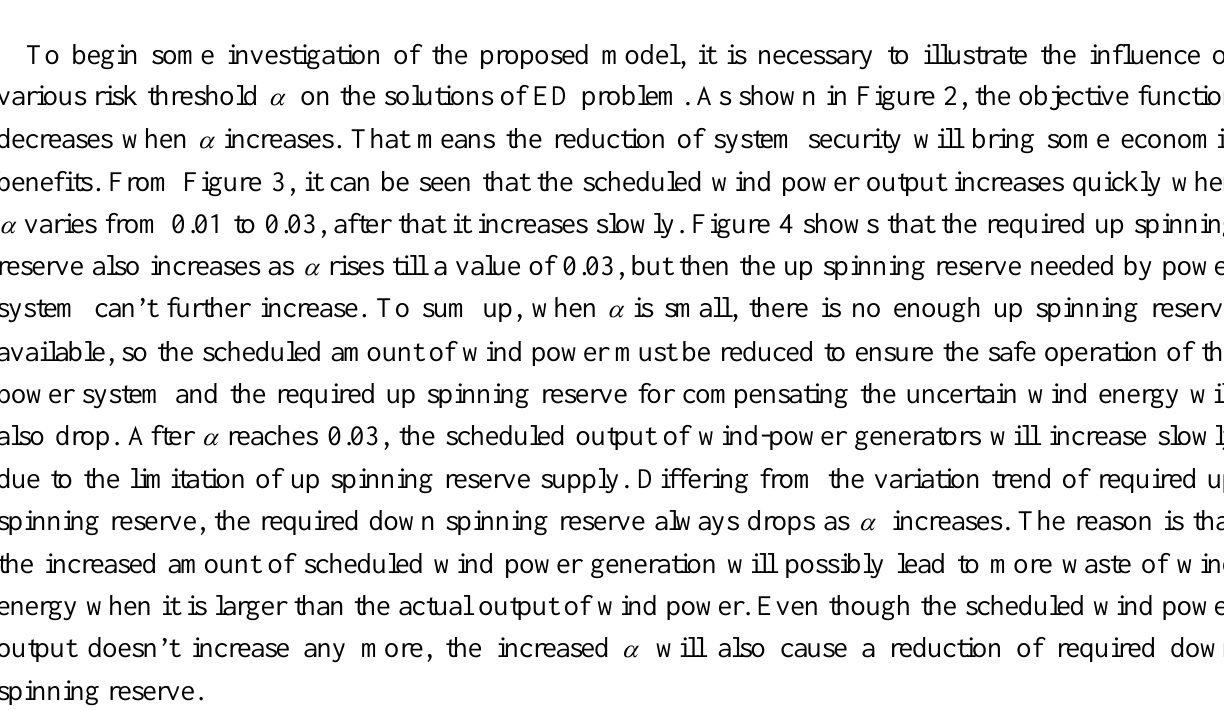
Figure 5. The total generation cost as a function of up reserve cost